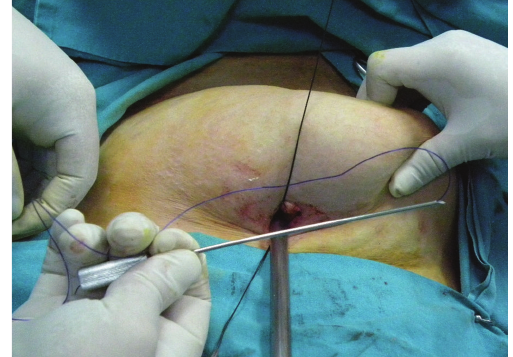
Figure 2: The preparation of the Veress cannula. The needle of the Veress cannula was removed, and one tip of a no. 0 nylon suture was inserted approximately 8–10cm into the Veress cannula.